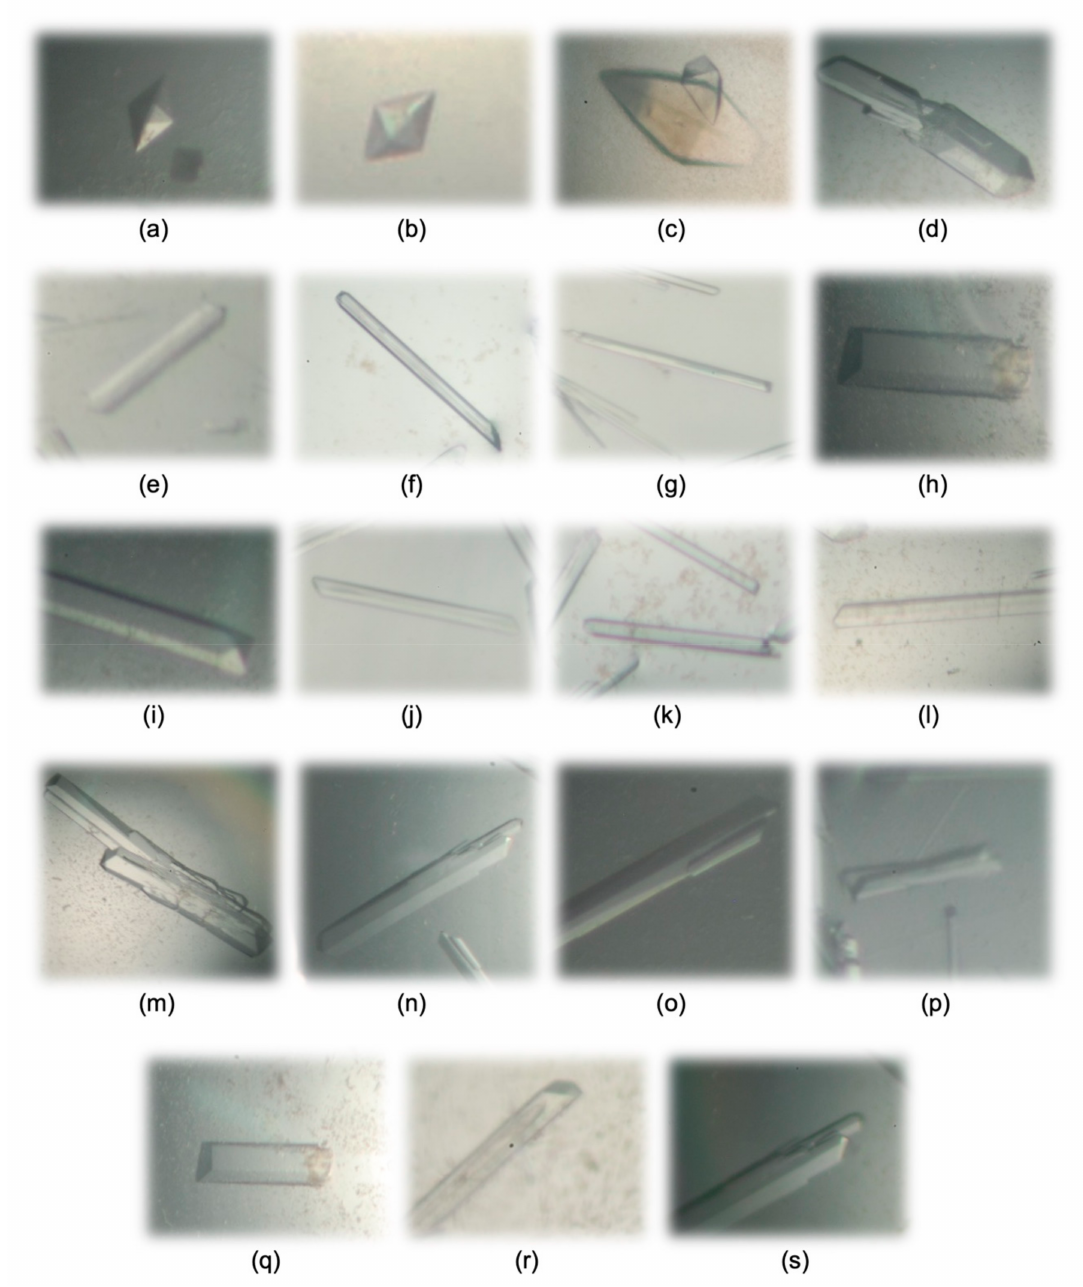
Figure 3. Crystals of cL-BABP ( a – r ) and of its CA-complex ( s ) grew using different crystallization conditions (Table 1). These crystals were selected to perform the X-ray crystallographic